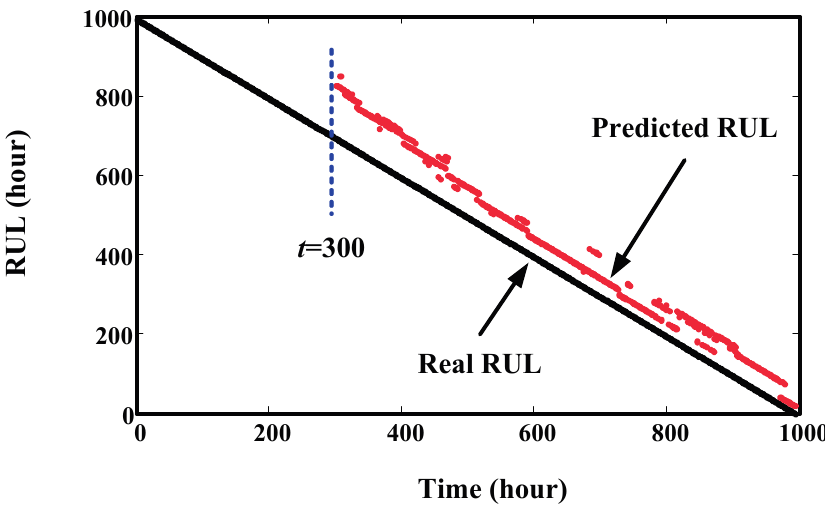
Figure 14. Prediction results of Component 2 at different time points.